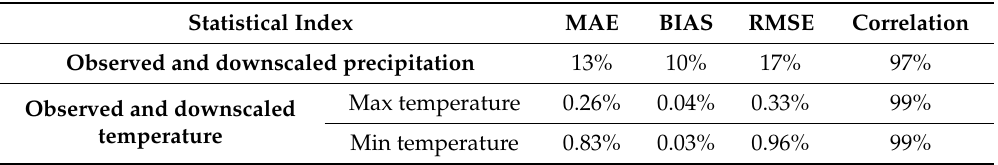
Table 1. Values of statistical indices between observed and downscaled monthly mean precipitation and temperature in the validation period (1986–2000).